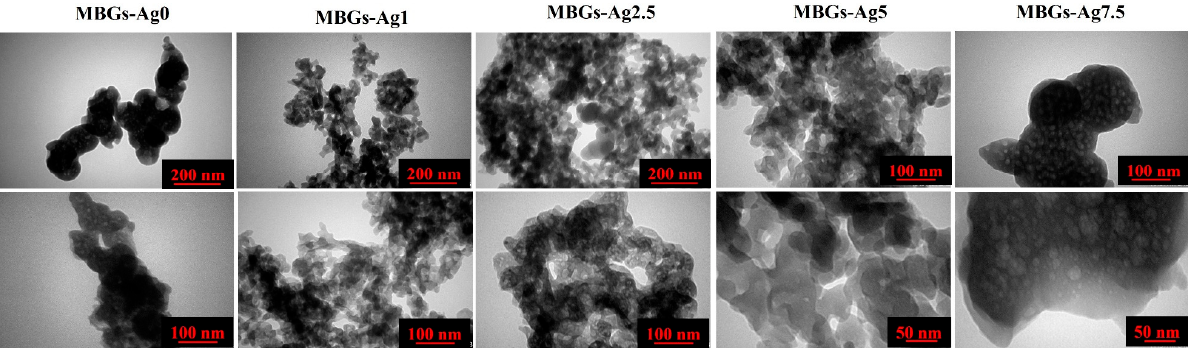
Figure 7. TEM images of the Ag-free and Ag-doped MBGs.